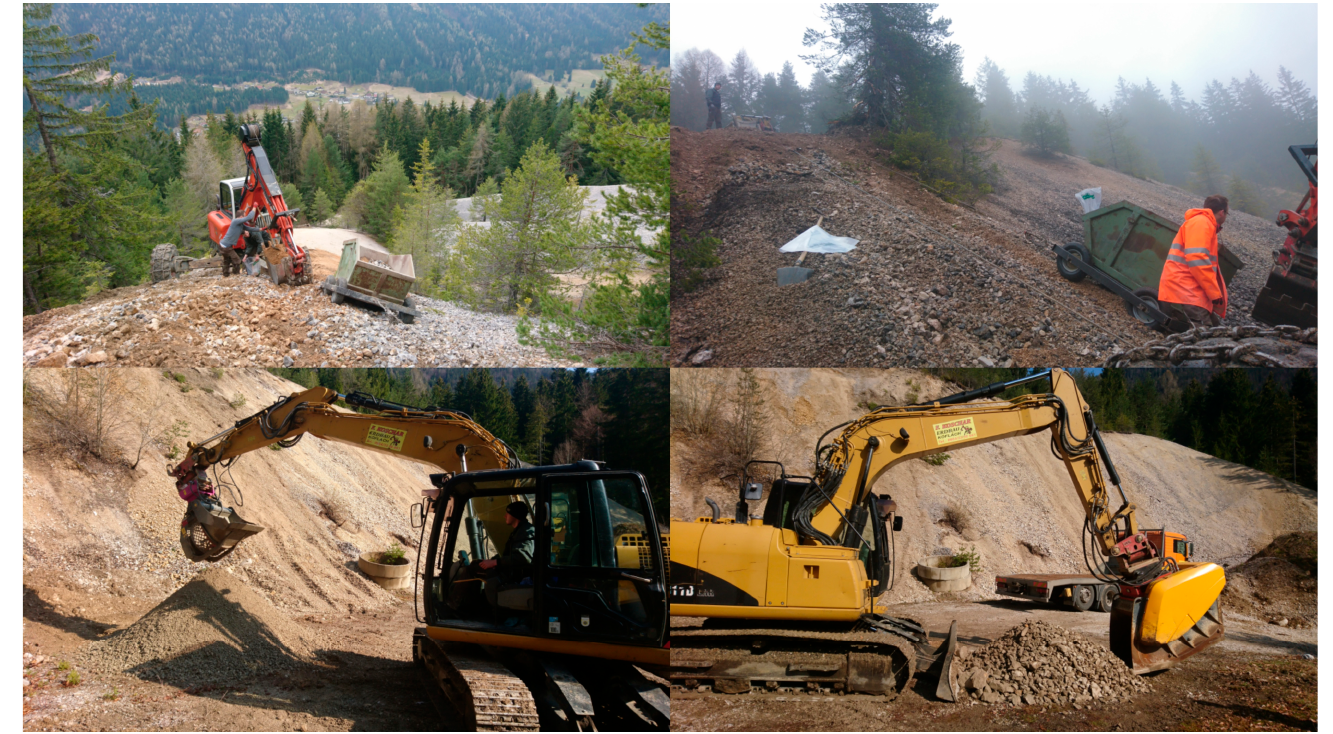
Figure 3. Second on-site sampling survey. Sampling using a walking excavator and a custom-built sample cart on a winch— top left and right . Bottom left —screening at 40 mm; bottom right —crushing of coarse particles +40 mm.